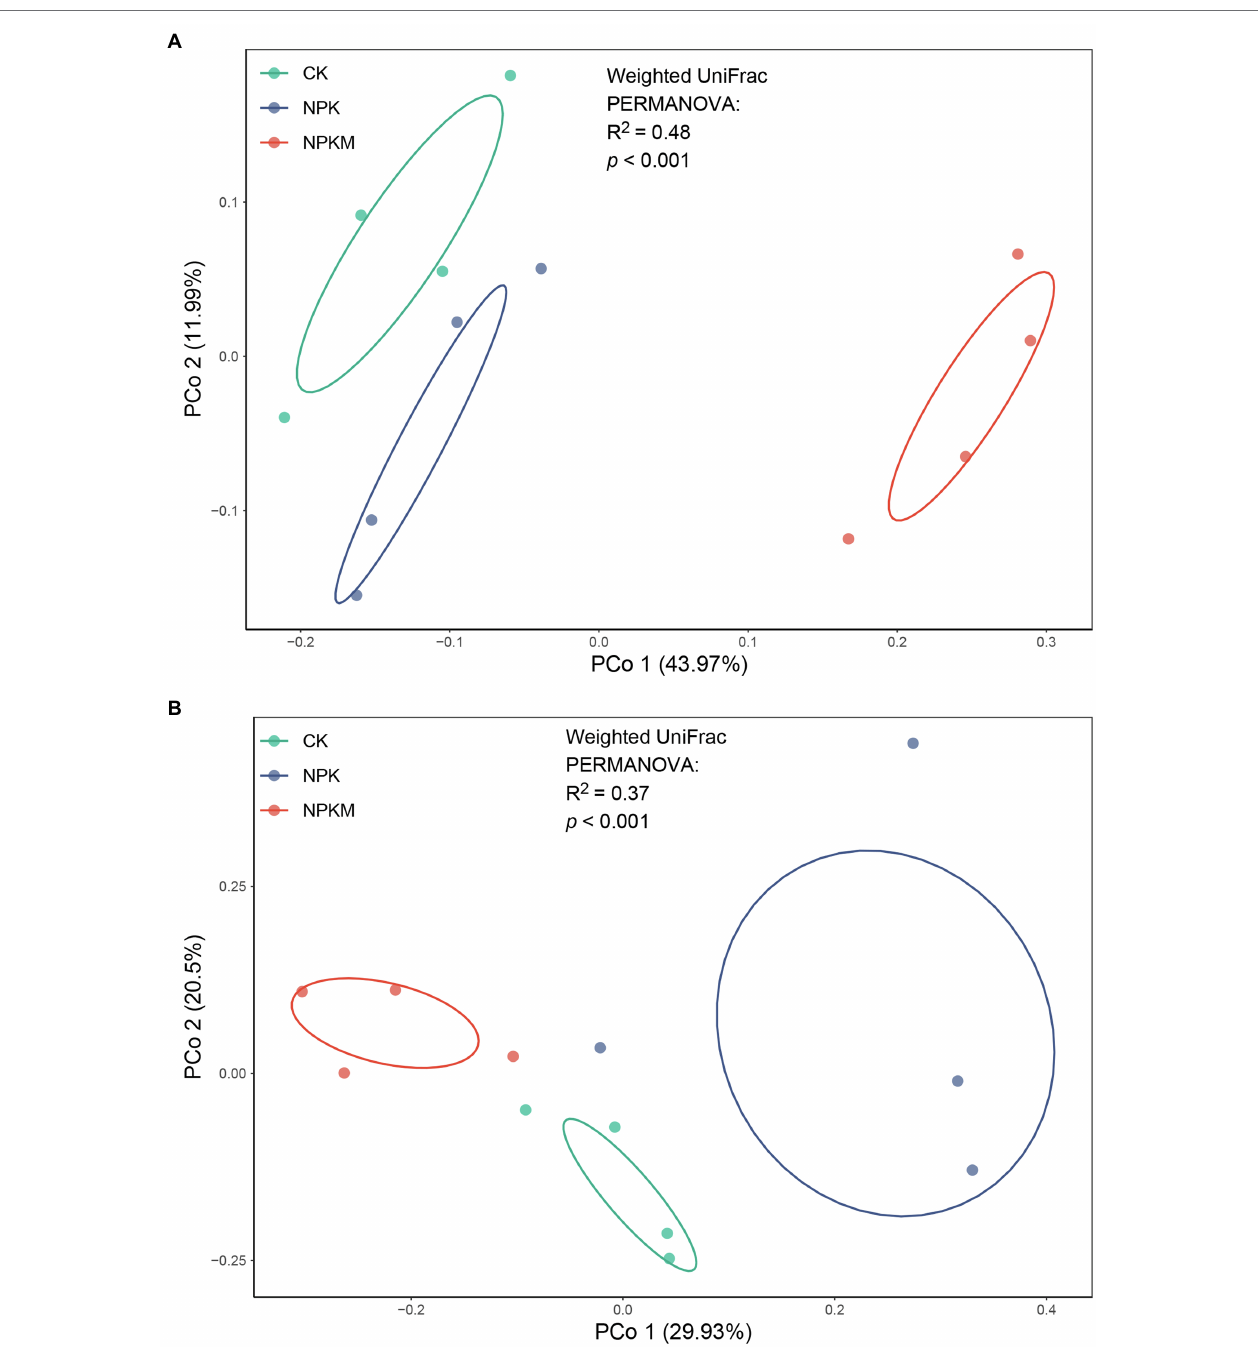
FIGURE 3 | Unconstrained principal coordinate analysis (PCoA) with weighted UniFrac distance showing effects of long-term fertilization treatments on beta- diversity of soil (A) bacterial and (B) fungal